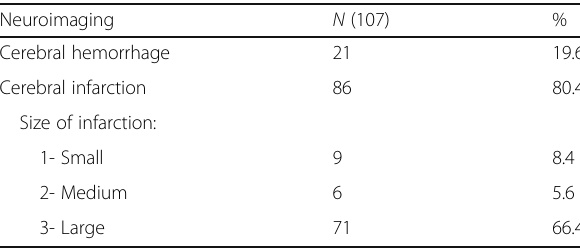
Table 2 Neuroimaging